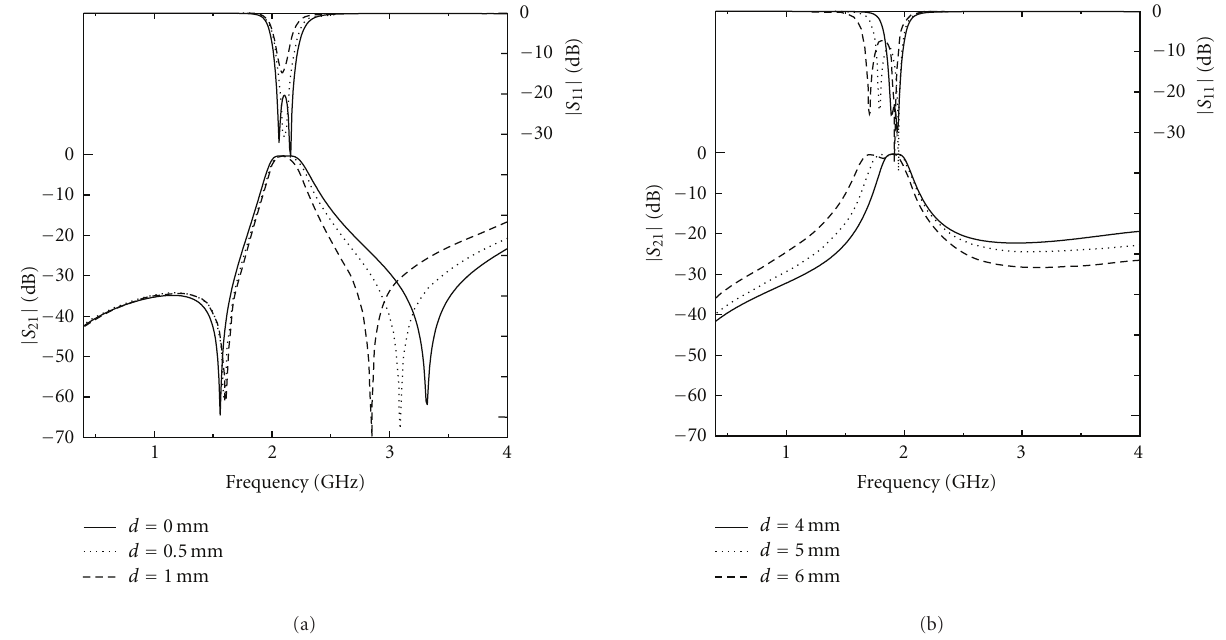
Figure 6: Frequency characteristics of scattering parameters when (a) d = 0 ∼ 1 . 0mm and (b) d = 4 . 0 ∼ 6 . 0 mm ( a = 5 . 2 mm).